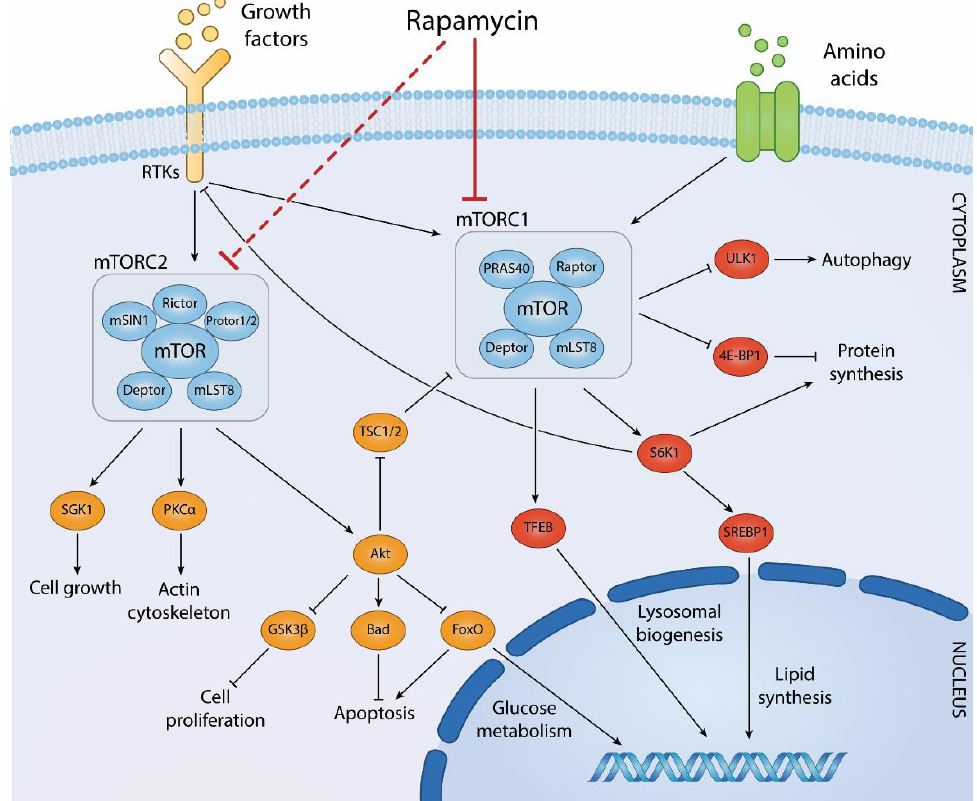
Figure 1. Biological processes regulated by mTOR complexes and downstream effector pathways. Both mTORC1 and mTORC2 are activated downstream of growth factors binding to cell surface receptors, such as receptor tyrosine kinases (RTKs), while mTORC1 receives stimulatory inputs also by amino acids. The diagram reports mTOR binding partners within mTORC1 and mTORC2 as well as their best-established downstream effector molecules in the indicated biological processes. Within the nucleus, signaling molecules downstream of mTOR signaling regulate gene expression programs involved in glucose metabolism, lysosomal biogenesis, and lipid synthesis. The diagram includes the negative feedback emanating from the mTORC1 effector S6K1 on RTKs downstream signaling. The allosteric mTOR inhibitor rapamycin primarily inhibits mTORC1 but also mTORC2 upon prolonged exposure of cells to the drug.